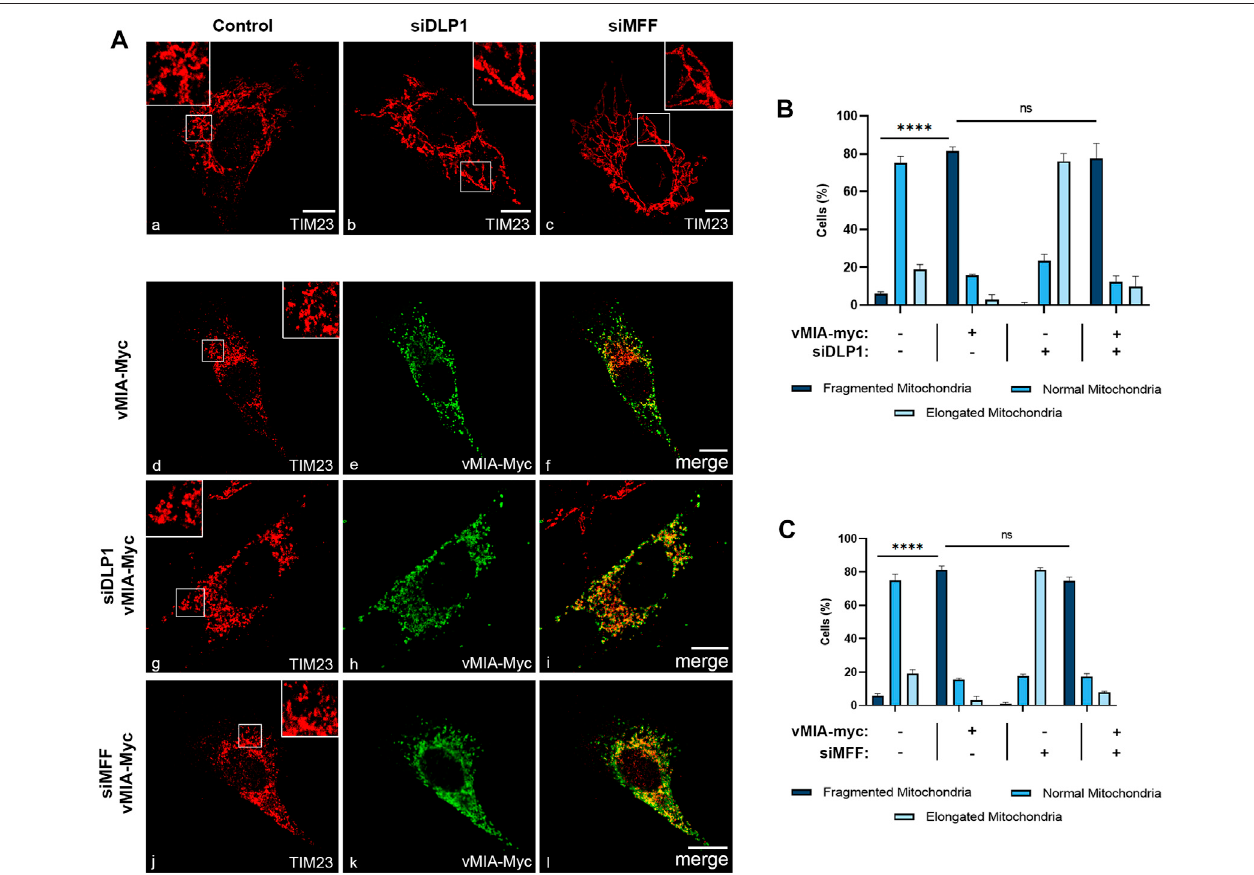
FIGURE 2 | vMIA-mediated mitochondrial fragmentation is independent on the fi ssion machinery proteins DLP1 and MFF. (A) Immuno fl uorescence analyses of MEFs MAVS-MITO cells: (a) control cells, (b) DLP1 silenced cells, (c) MFF silenced cells: (a – c) anti-TIM23; (d – f) overexpression ofvMIA-Myc: (d) anti-TIM23, (e) anti-Myc, (f) merge image of d and e; (g – i) overexpression of vMIA-Myc in DLP1 silenced cells: (g) anti-TIM23, (h) anti-Myc, (i) merge image of g and h; (j – l) overexpression ofvMIA- Myc in MFF silenced cells: (j) anti-TIM23, (k) anti-Myc, (l) merge image of j and k. Bars represent 10 µm. (B,C) Statistical analysis of mitochondrial morphologies upon overexpression of vMIA-Myc in MEFs MAVS-MITO cells in the absence of DLP1 or MFF, respectively. Approximately 600 cells were analysed per condition. Data representsthemeans±SEMofthreeindependentexperimentsanalysedusingtwo-wayANOVAwithBonferroni ’ smulticomparationstest(ns=non-signi fi cant,**** – p < 0.0001). Error bars represent